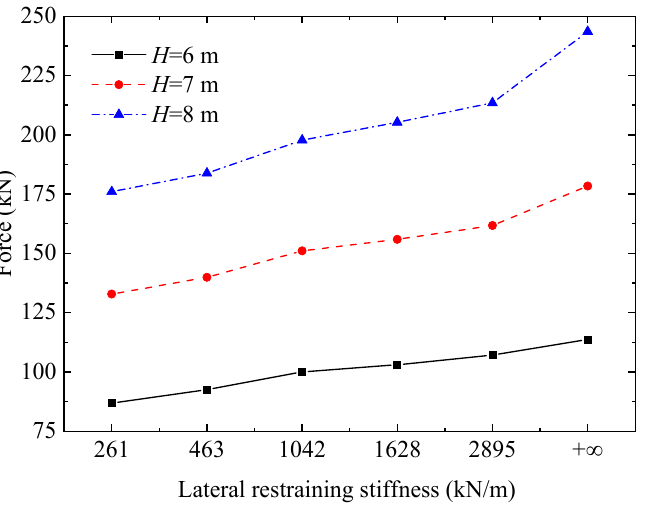
Figure 18. Influence of the lateral restraining stiffnesses on the horizontal force for Case E23/Cs (1).